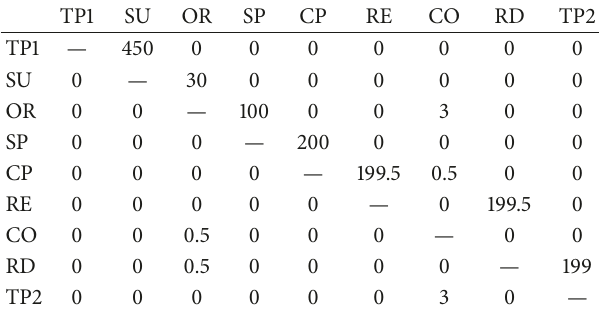
Table 2: Distance matrix of the original layout [ 𝐷 1 ].